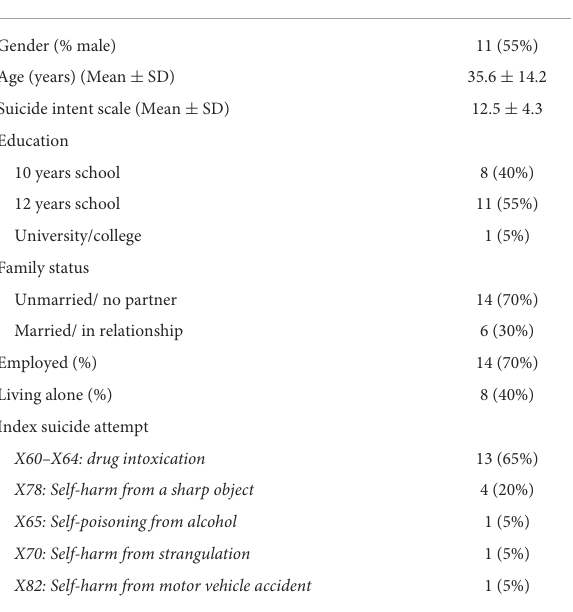
TABLE 1 Sociodemographic and suicide attempt related characteristics of the final sample.